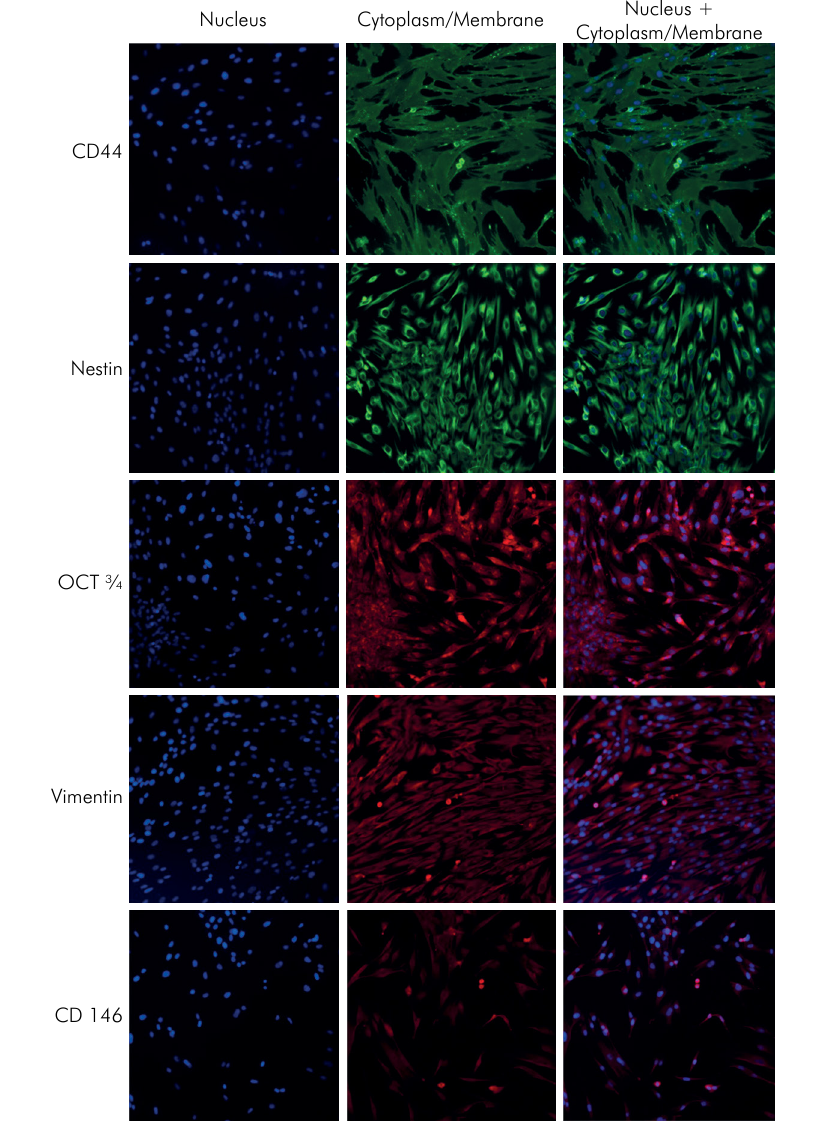
Figure 7. Panel representing the microscope fluorescence images of dental pulp stem cells (DPSCs, EX technique, passage 5, 29-year-old donor) marked positively for CD44, CD146 (cell membrane) Vimentin, Nestin and OCT3/4 (cytoplasm). X20.